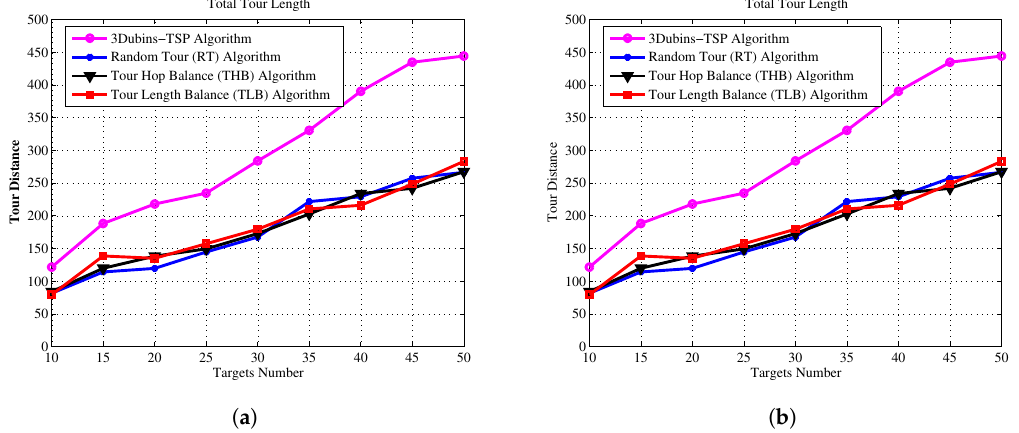
Figure 11. Energy consumption comparisons. ( a ) 2 AUVs; ( b ) 4